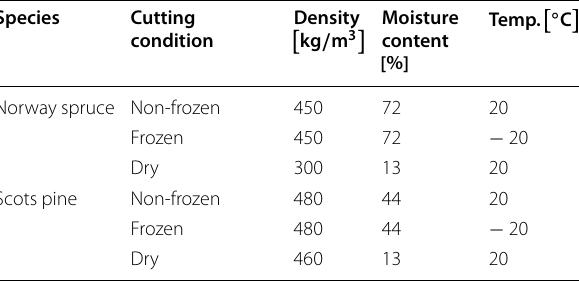
Table 1 Average density, moisture content and temperature of Norway spruce and Scots pine samples just before being cut Species Cutting condition